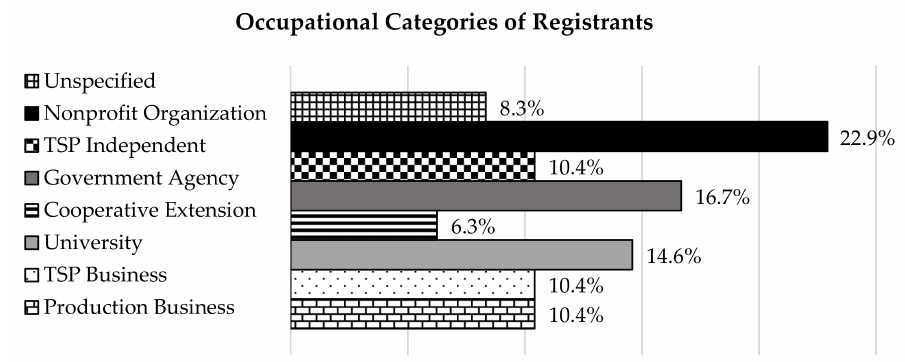
Figure 2. Occupational categories of registrants (n = 48). TSP = Technical Service Provider.